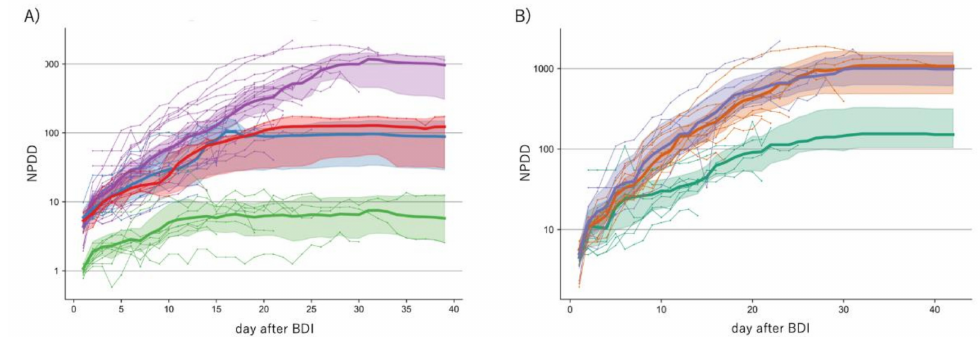
Figure 6. Estimation of the time course of NPDD after BDI by machine learning analysis classified by the global region (Panel ( A )) and by the positive rate of the PCR test (Panel ( B )). In Panel ( A ), yellow-green, red, blue, and purple lines indicate countries in Asia (excluding the Middle East), the Middle East, Latin America, and Western (Europe, Oceania, and North America), respectively. In Panel ( B ), only Western countries were analyzed. Green, orange, and blue lines indicate the positive rates of 0.0–6.9%, 7.0–16.9%, and 17.0–28.0%, respectively. Each colored area represents a 5–95% confidence interval of the median estimated by bootstrap analysis. NPDD: number of population-adjusted daily deaths. BPI: beginning of the test-positive cases